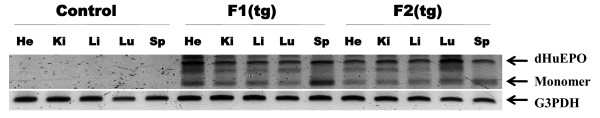
Expression of dHuEPO mRNA in the tissues of the transgenic mice. No PCR bands were detected in the control mice. The expected dimeric and monomeric PCR bands were found in the F1 (tg) and F2 (tg) mice. The mice tissues tested were heart (He), kidney (Ki), liver (Li), lung (Lu), and spleen (Sp).